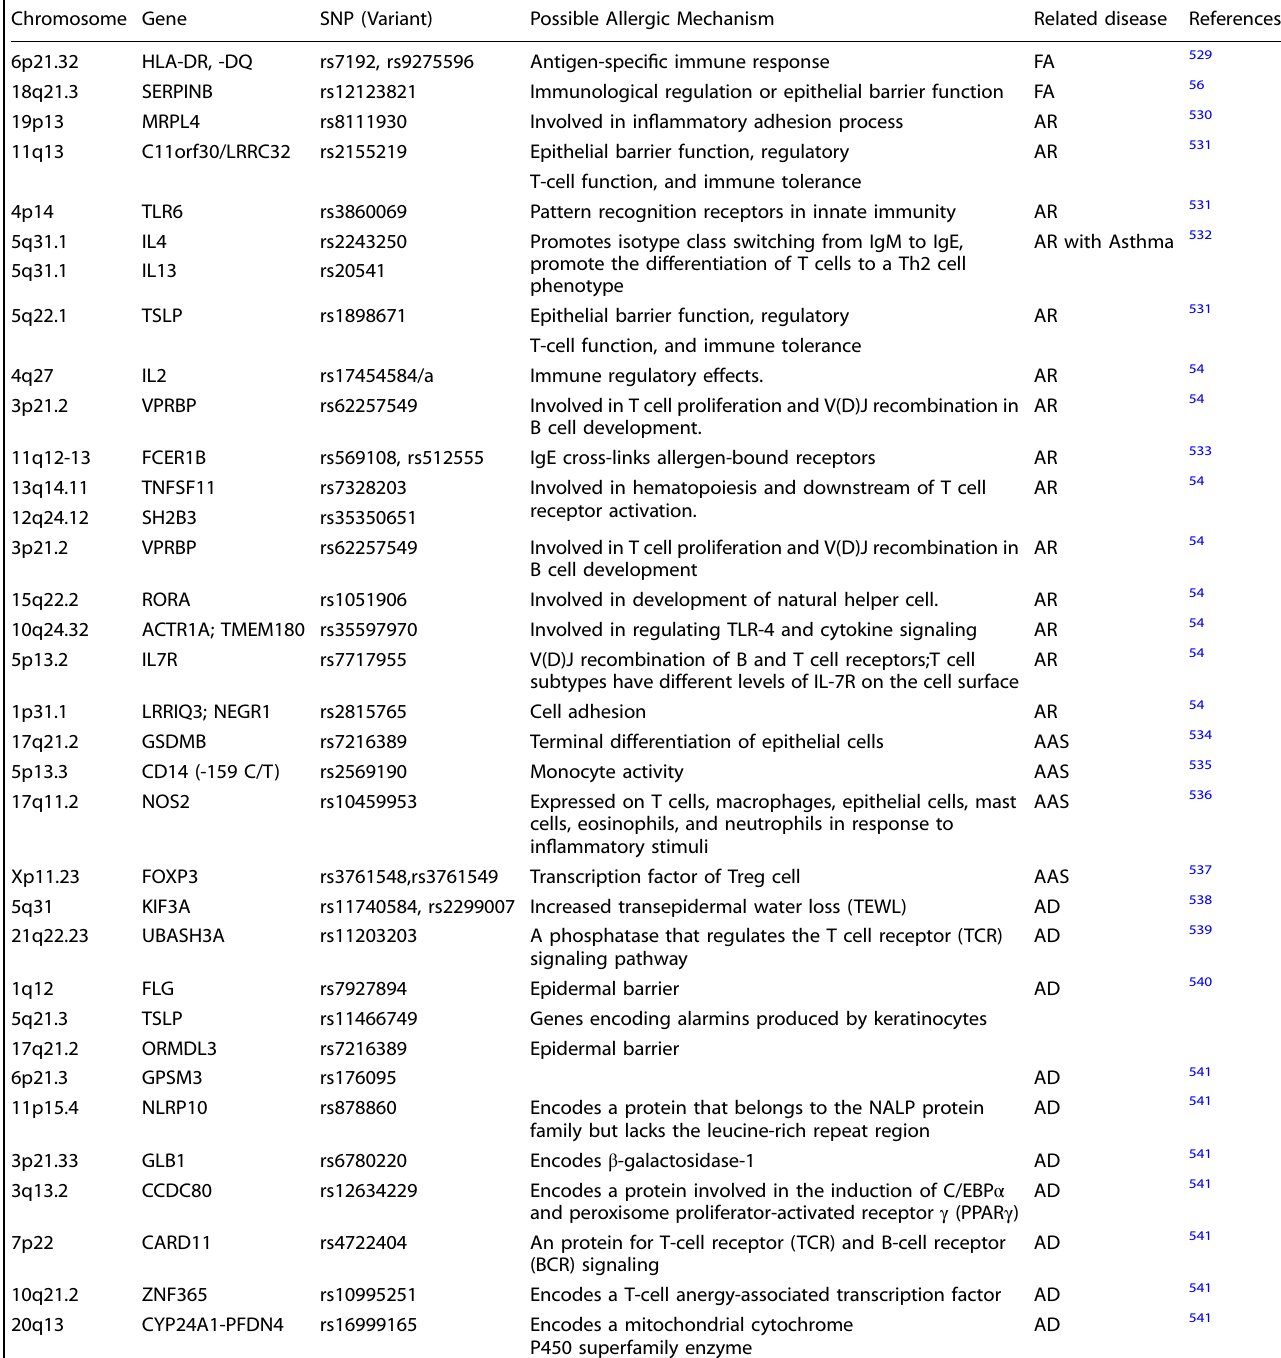
Table 1. Summary of genomic loci of allergic disease Chromosome